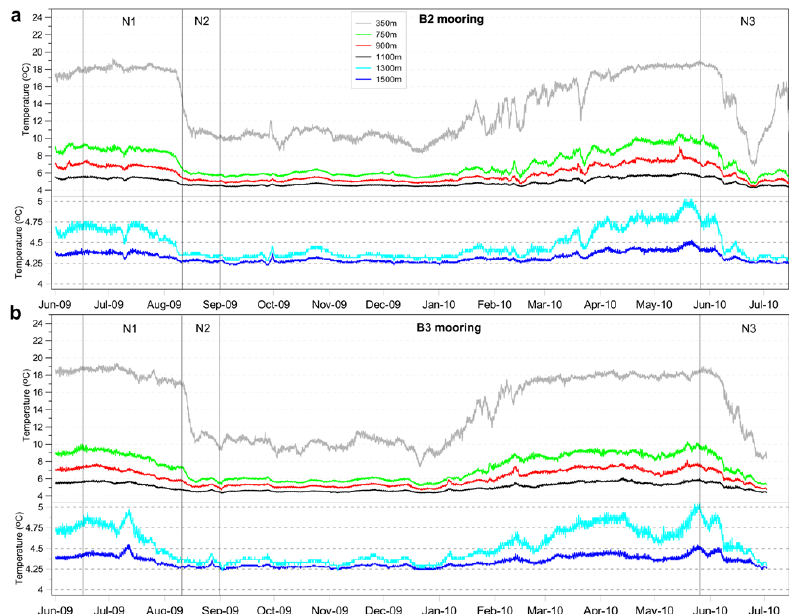
Figure 7. Sea temperature ( ◦ C) temporal evolution at several depths (350, 750, 900, 1100, 1300, and 1500m) from (a) B2 and (b) B3 moorings (Fig. 1) from June 2009 to mid-July 2010. The 1300 and 1500m time series are plotted with a different y axis for clarity reasons. The LCFE N1, N2, and N3 periods are indicated with black solid vertical lines.